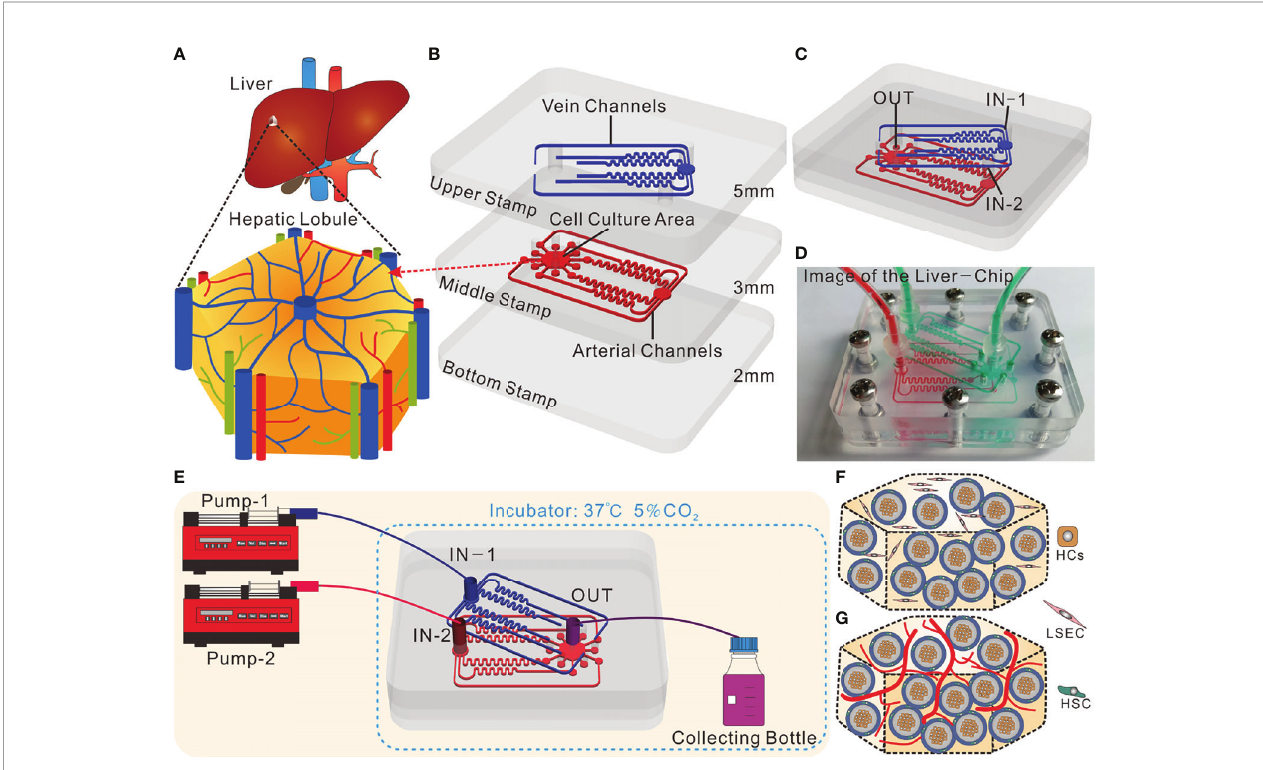
FIGURE 1 | Design and operation of the tri-vascular liver-on-a-chip (TVLOC). (A) Schematic of the in vivo hepatic lobule; (B) Schematic components of the TVLOC; (C) Schematic of the assembled TVLOC; (D) The physical picture of the assembled TVLOC; (E) Schematic of the TVLOC operation system; (F) Schematic of the cultivation at early stage in the culture area; (G) Schematic of the formation of vascularized liver tissue in the culture